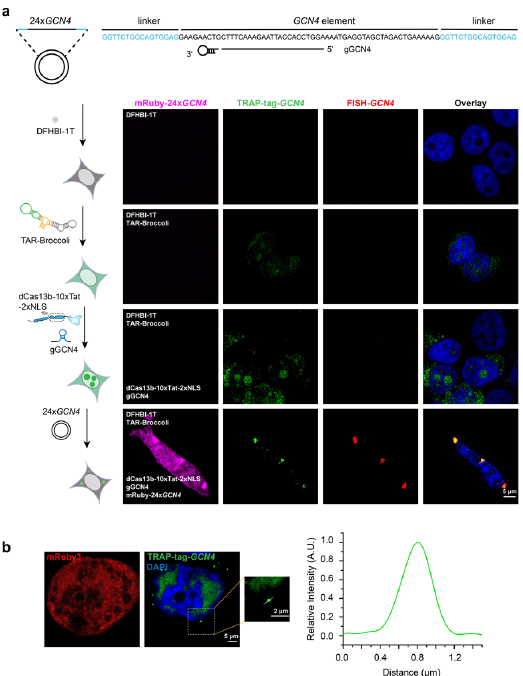
Figure 2. Labeling of exogenous GCN4 mRNAs using the CRISPR-TRAP-tag. ( a ) Schematic and image of applying the CRISPR-TRAP-tag to label GCN4 mRNAs. The sgRNA (single guide RNA) targeting repeats in GCN4 are shown. Images of the 24 × GCN4 labeled using TRAP-tag. First row, negative control; Second row, pTAR-Broccoli were transfected to the cells; Third row, cells were co-transfected with pdPspCas13b-10 × Tat-2 × NLS, pgGCN4, and pTAR-Broccoli. Bottom row, co-transfection of pdPspCas13b-10 × Tat-2 × NLS, pgGCN4, pTAR-Broccoli, and pmRuby3-24 × GCN4 was carried out. The nucleus was dyed using DAPI. ( b ) Partially enlarged image of TRAP-tag labeling GCN4 in 293T cells. The dotted line in the right panel indicates the line scan of the relative fluorescence intensity of the signal. The nucleus was dyed using DAPI. The diameter of the light point was about 0.5 µ m. A scale bar is shown in the figure. The cell was treated with DFHBI-1T (10 µ